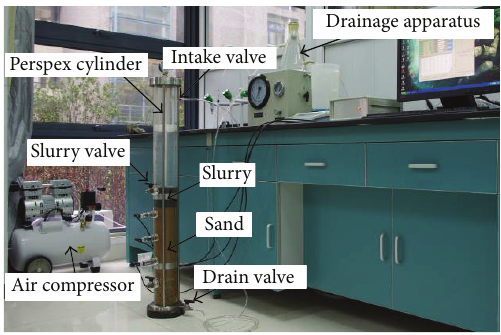
Figure 1: Filter cake air tightness test apparatus.